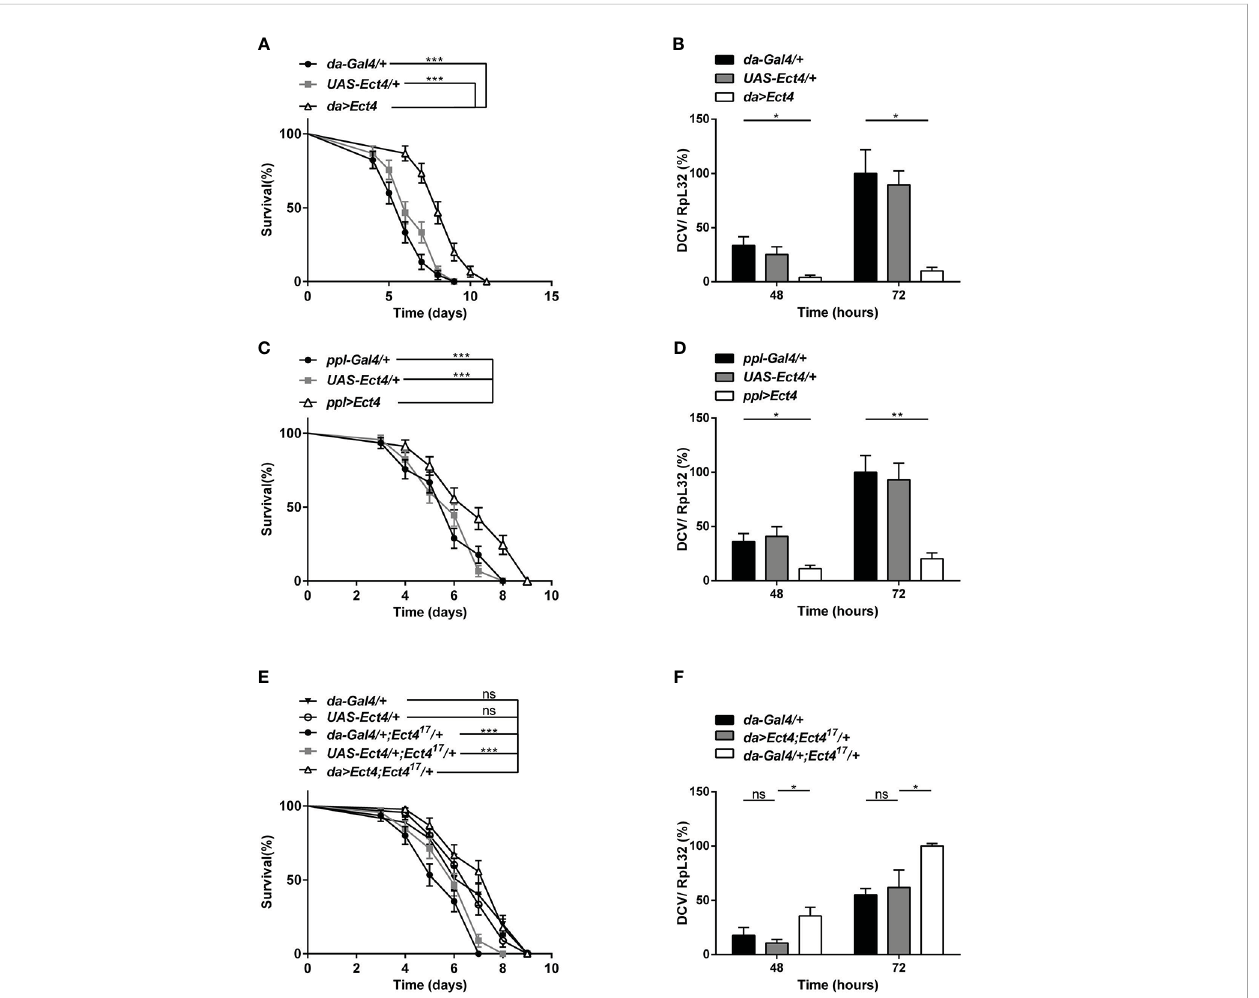
FIGURE 2 Overexpression of Ect4 provides strong protection against DCV. (A) Survival of fl ies expressing Ect4 transgene in whole fl ies by da-Gal4 driver and control fl ies following DCV infection. (B) Quantitative RT-PCR analysis of the accumulation of viral RNA at 48 and 72 h post-infection in Ect4 overexpression and control fl ies. (C) Survival of fl ies expressing Ect4 transgene speci fi cally in the fat body by the ppl-Gal4 driver and control fl ies following DCV infection. (D) Quantitative RT-PCR analysis of the accumulation of viral RNA at 48 and 72 h post-infection in Ect4 overexpression and control fl ies, speci fi cally in the fat body. (E) Survival of Ect4 mutant fl ies expressing Ect4 transgene under the control of da-Gal4 and control fl ies post- DCV infection. (F) Quantitative RT-PCR analysis of the accumulation of viral RNA at 48 and 72 h post-infection in control or Ect4 mutant fl ies expressing Ect4 transgene. Data represent the means ± standard errors of 3 independent pools of 15 male fl ies (A, C, E) or 10 male fl ies (B, D, F) for each genotype. Log-rank test (A, C, E) and t- test (B, D, F) : * P < 0.05, ** P < 0.01, *** P < 0.001, ns, not signi fi